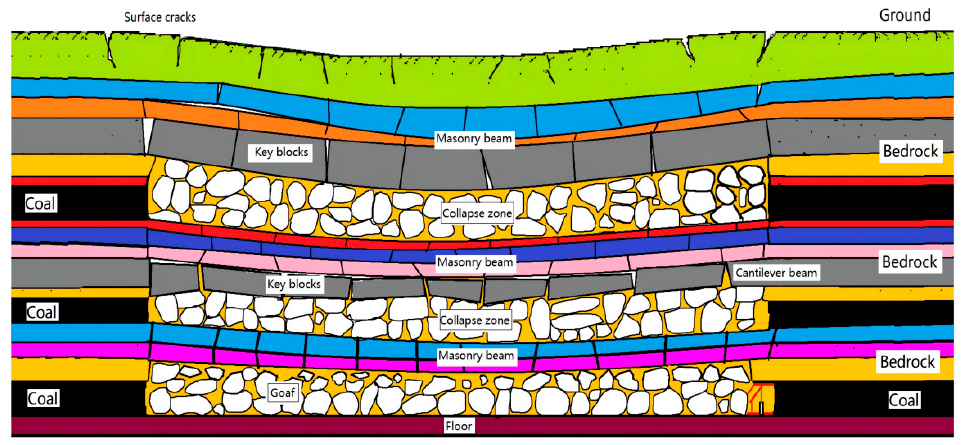
Figure 8. Schematic of bedrock failure in mining of MCS.